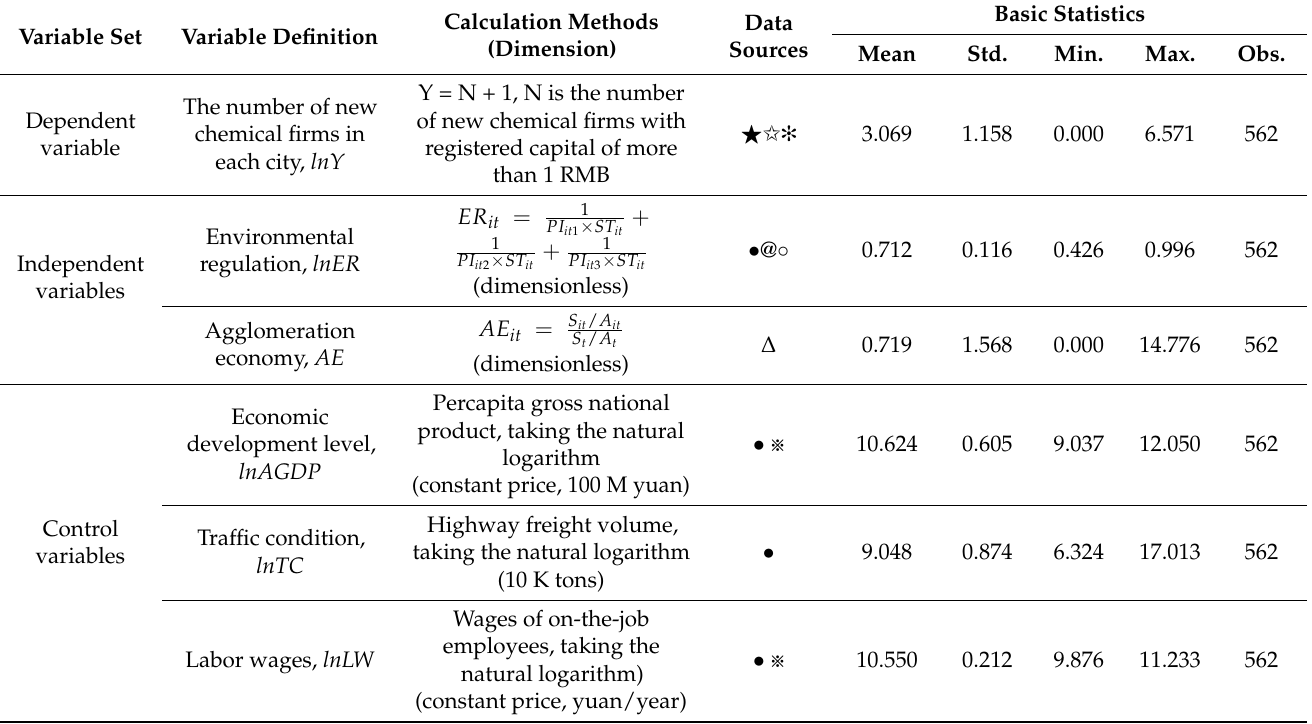
Table 1. Calculation methods, sources of variables and their basic statistical